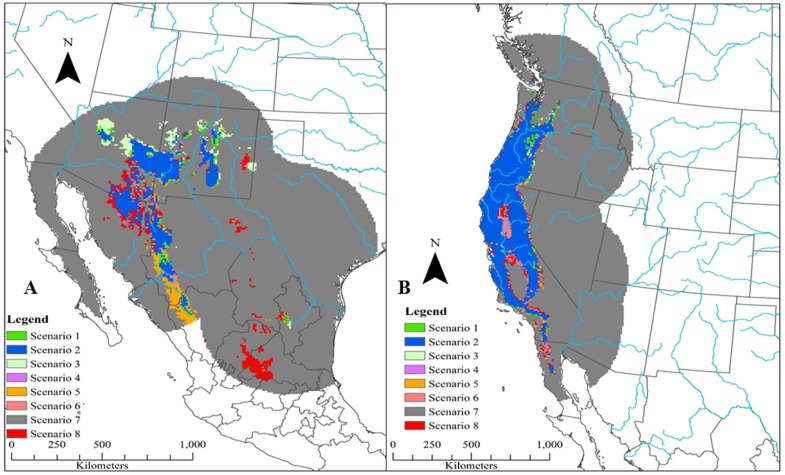
Future predicted changes in distributions of Montezuma quail (Cyrtonyx montezumae; a) and mountain quail (Oreortyx pictus; b) projected to 2070 and based on ensemble forecasts (estimated through Maxent) at 90% agreement.Major rivers of North America (blue lines) are included for geographic reference. Full descriptions for possible distribution conditions are given in Table 2. In short, distribution conditions represent: condition 1 (distribution expansion from current to 2050 and remaining suitable from 2050 to 2070), condition 2 (suitable at current and through all time periods), condition 3 (unsuitable from current to 2050 but expanding from 2050 to 2070), condition 4 (distribution contraction from current to 2050 but expanding from 2050 to 2070), condition 5 (distribution expansion from current to 2050 but contracting from 2050 to 2070), condition 6 (suitable from current to 2050 but contracting from 2050 to 2070), condition 7 (unsuitable at current and through all time periods), and condition 8 (distribution contraction from current to 2050 and remaining unsuitable from 2050 to 2070).